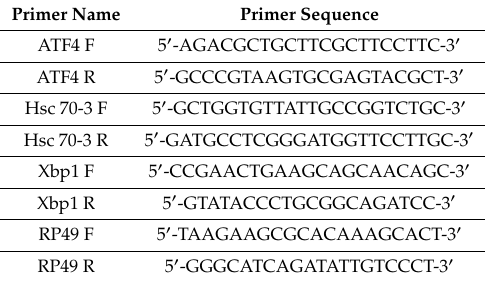
Table 2. Primers used for